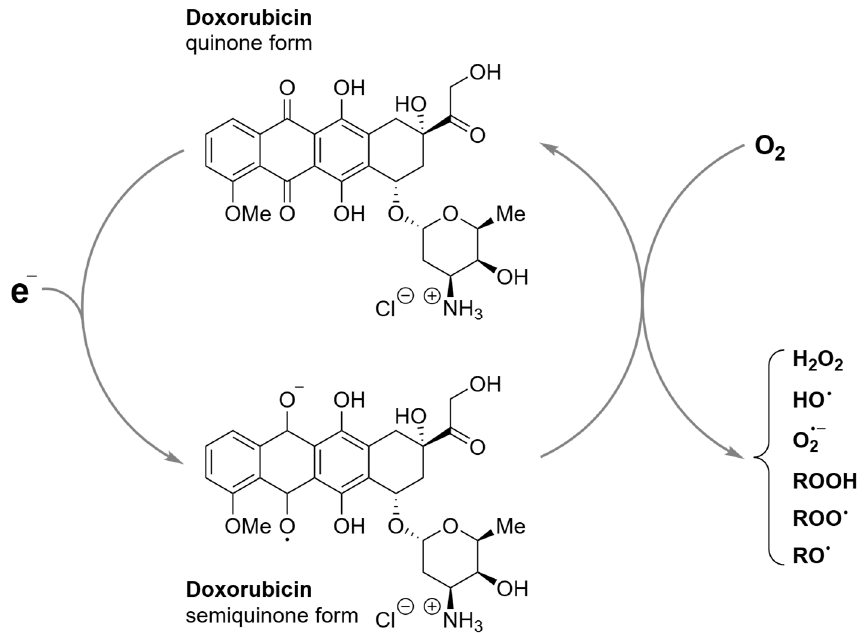
Figure 1. Redox cycling of doxorubicin. One-electron reduction of the quinone moiety mediated by the cellular oxidoreductases results in the formation of a semiquinone radical that regenerates the parent quinone by reducing an oxygen molecule to a superoxide radical. This initiates a reaction cascade leading to the formation of other ROS.